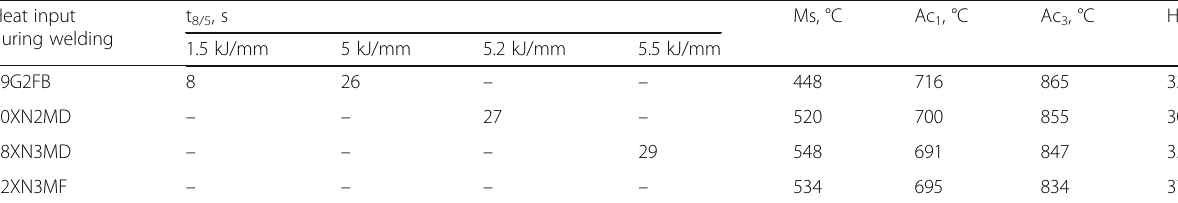
Table 5 Calculated values for the studied steels Heat input during welding